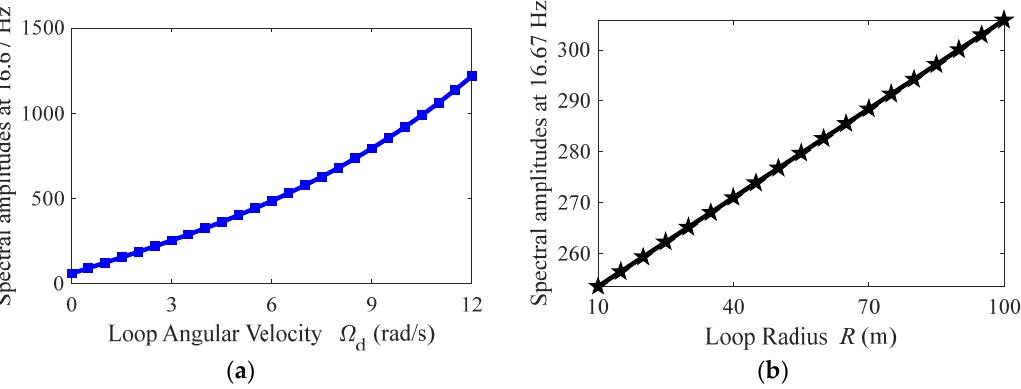
Figure 14. Spectra amplitude of the dynamic meshing force of sun-planet1 at 16.67 Hz. ( a ) At differ- ent LAV; ( b ) At different LR.